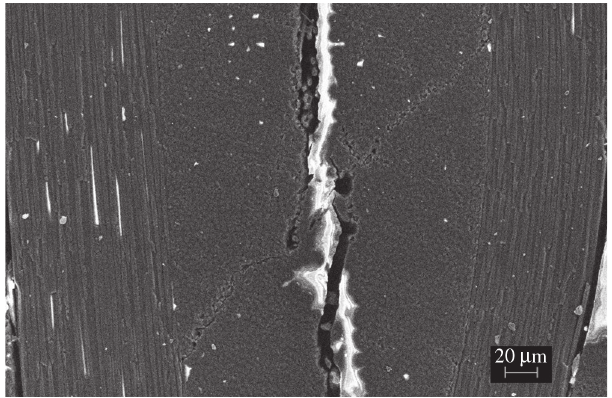
Figure 9. Fractograph of interface region of wet carbon/BMI fabric laminate (2.4% of moisture).